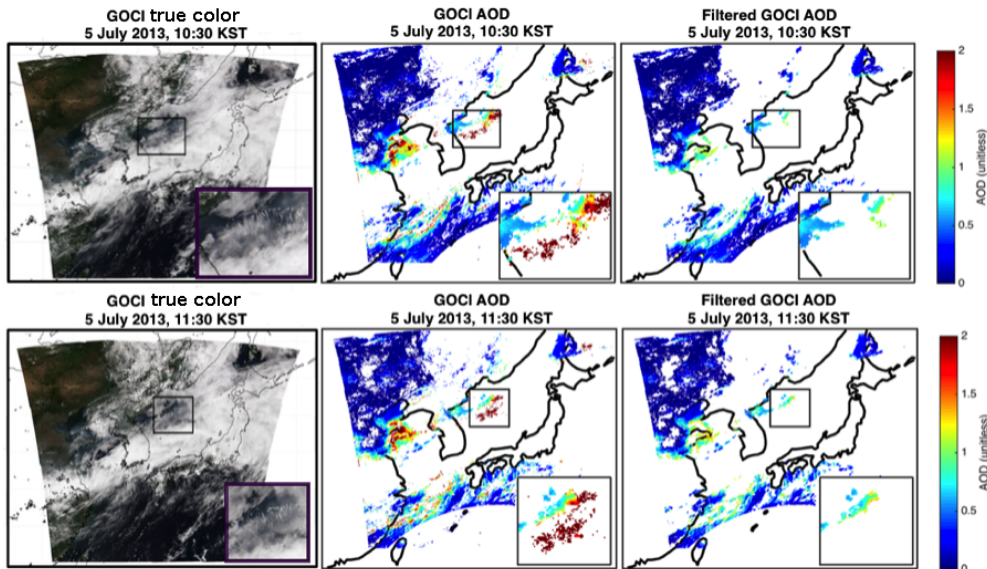
Figure 1. The GOCI granules from 5 July 2013, 10:30 (top) and 11:30 (bottom) Korean Standard Time. From left to right on each panel are the GOCI true color images, the operational AOD retrievals and the AOD retrievals after applying temporal and textual filters to reduce cloud contamination. The boxes highlight examples of challenging cloud fields, and are enlarged within the lower right subplot of each